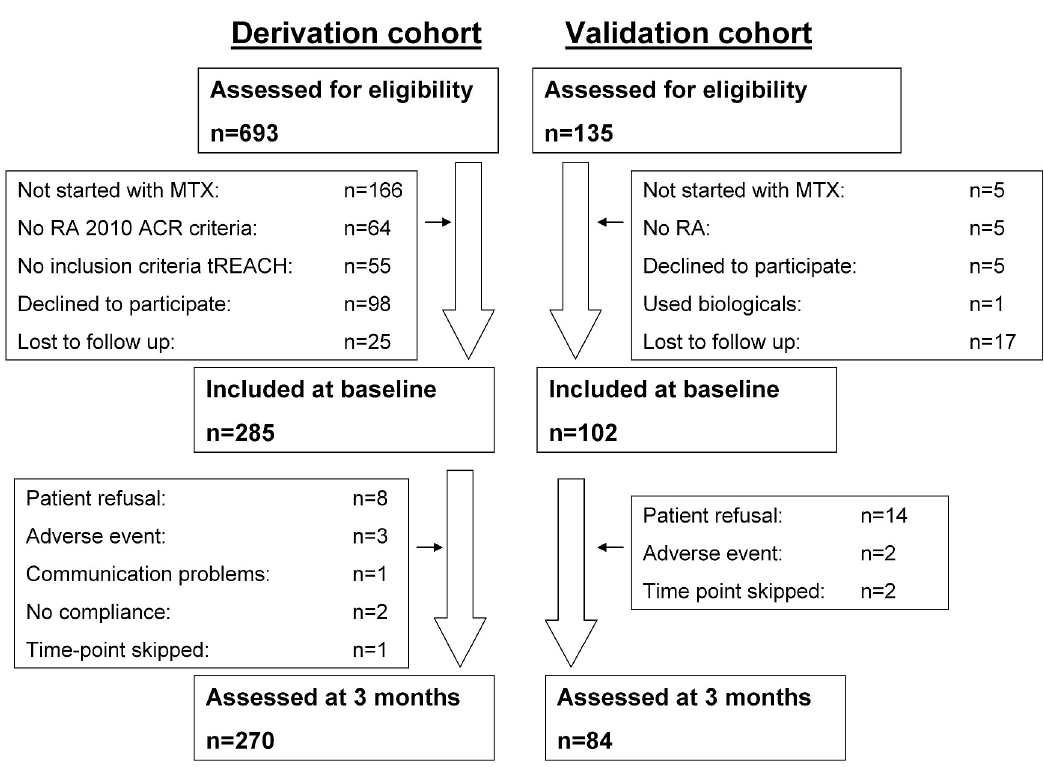
Fig 1. Flow chart of patient follow up divided in the derivation and validation cohorts. MTX, methotrexate; RA, rheumatoid arthritis; ACR, American College of Rheumatology; tREACH, treatment in Rotterdam Early Arthritis